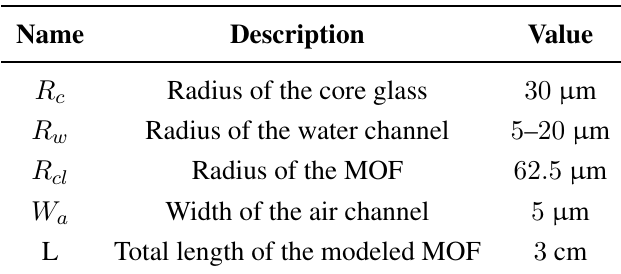
Table 2. MOF geometry